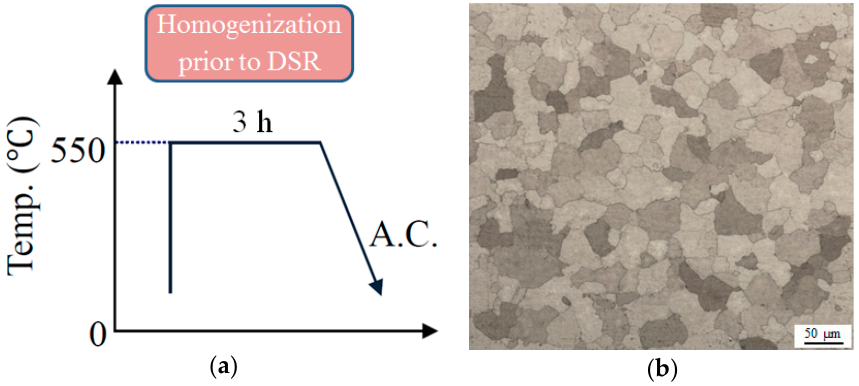
Figure 1. ( a ) Homogenization conditions of the as-received 6061 Al alloy sheets and ( b ) the obtained microstructure (DSR: Differential Speed Rolling; A.C.: Air Cooled).